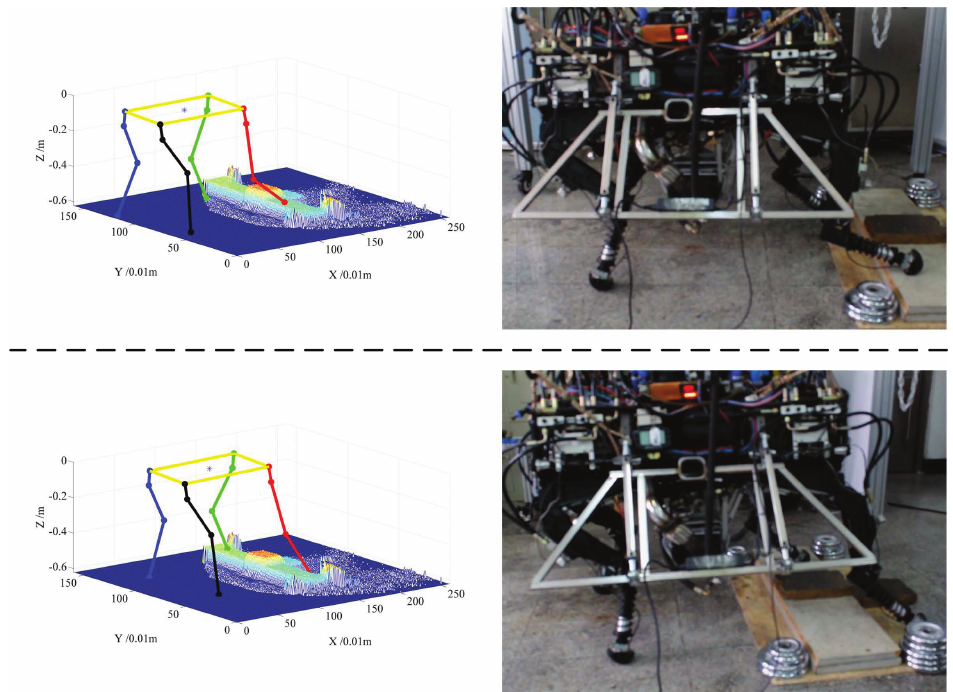
Figure 12. Screenshots of walking across the step, and corresponding poses of the robot on the elevation map, the upper panel shows a case of lifting and placing the right front foot on the step, and the lower panel shows cases of putting the foot onto the